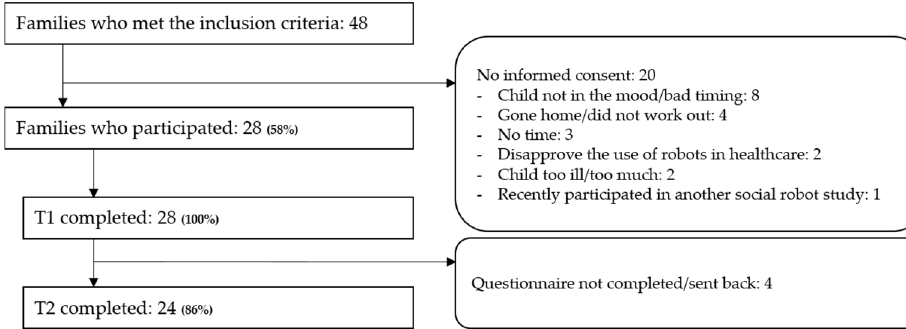
Figure 3. Flowchart of participants and reasons for not participating. Note: T1—interactive sleep